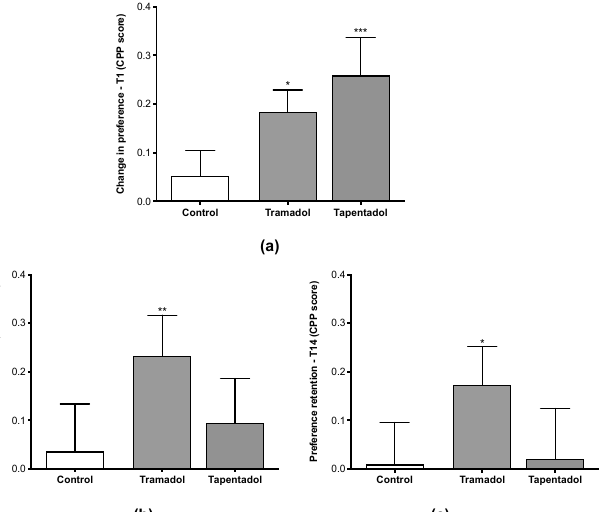
Figure 2. Change in place preference at T1 ( a ), T7 ( b ) and T14 ( c ) time points. Change in preference was assessed by measuring the difference between CPP scores 1 ( a ), 7 ( b ) and 14 ( c ) days after the last drug administration (conditioning phase) and the CPP score in the preconditioning phase. In the conditioning phase, rats received daily intraperitoneal injections of 50 mg/kg tramadol or tapentadol, alternating with normal saline, for 8 days, and were immediately allowed to stay in a pre-determined (drug-paired: non-preferred; saline-paired: preferred) compartment. Control animals received daily intraperitoneal injections of normal saline for the same period. Results were recorded with the PPCWIN software, version 2.0 (Panlab, ref. 76-0011), and are expressed as means ± SD ( n = 9). * p < 0.05; ** p < 0.01; *** p < 0.001.